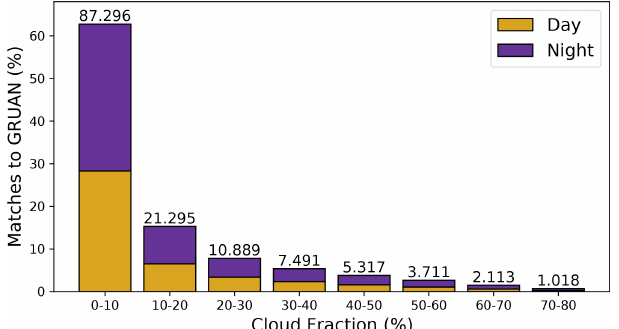
Figure 9. Stacked histogram of IMS collocations to GRUAN sites split into 10% cloud cover intervals. Results are separated into day and night cases, with the total number of matches shown at the top of each bar. A further subdivision of the first bin (0-10%) can be seen in Fig. B1 of Appendix